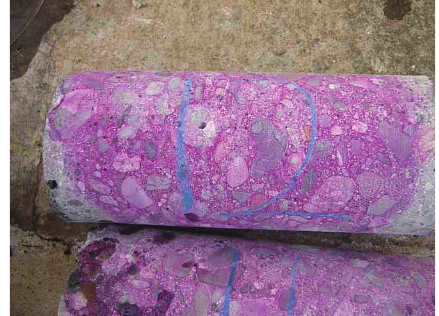
Figure 15: Carbonation test of core-drilled